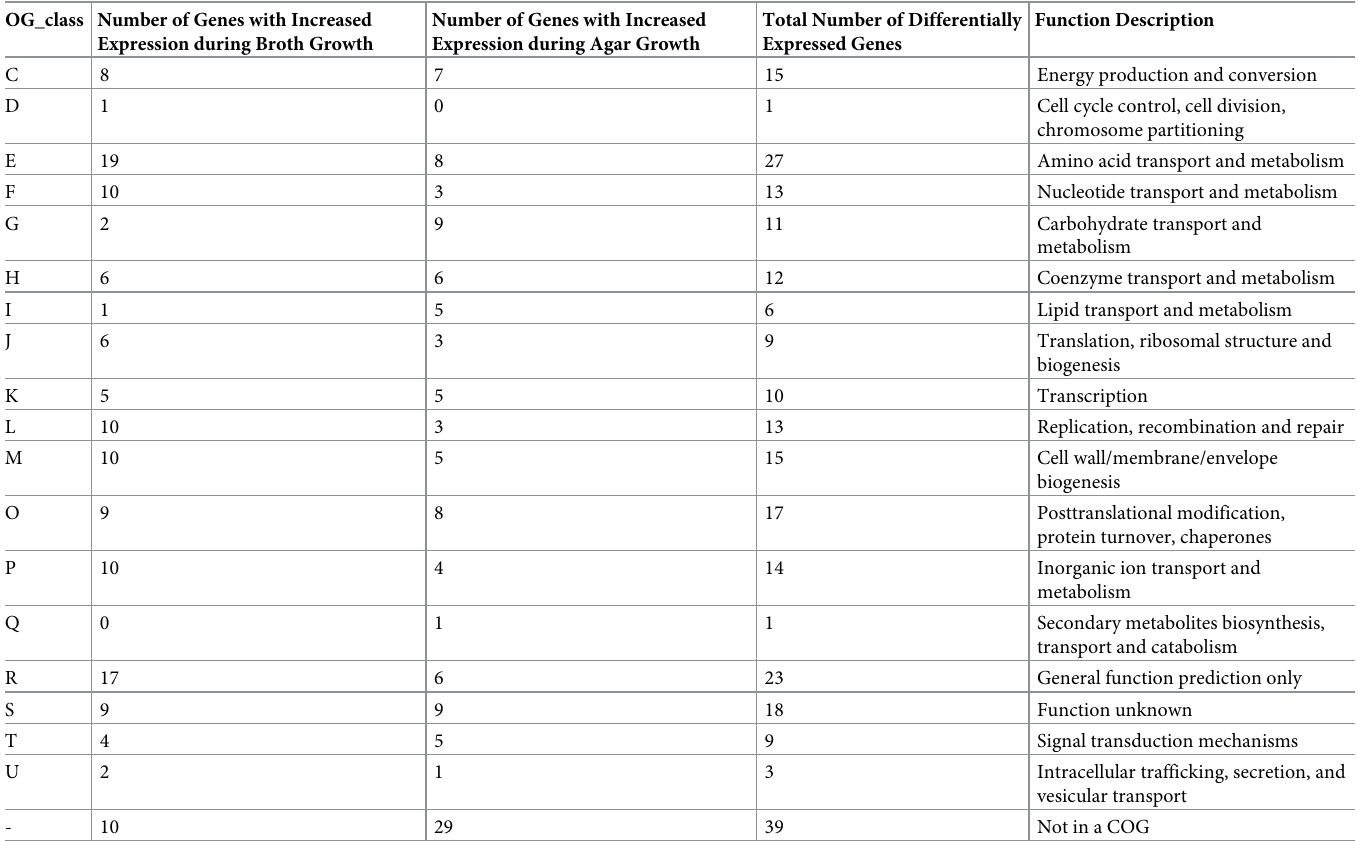
Table 1. COG analysis